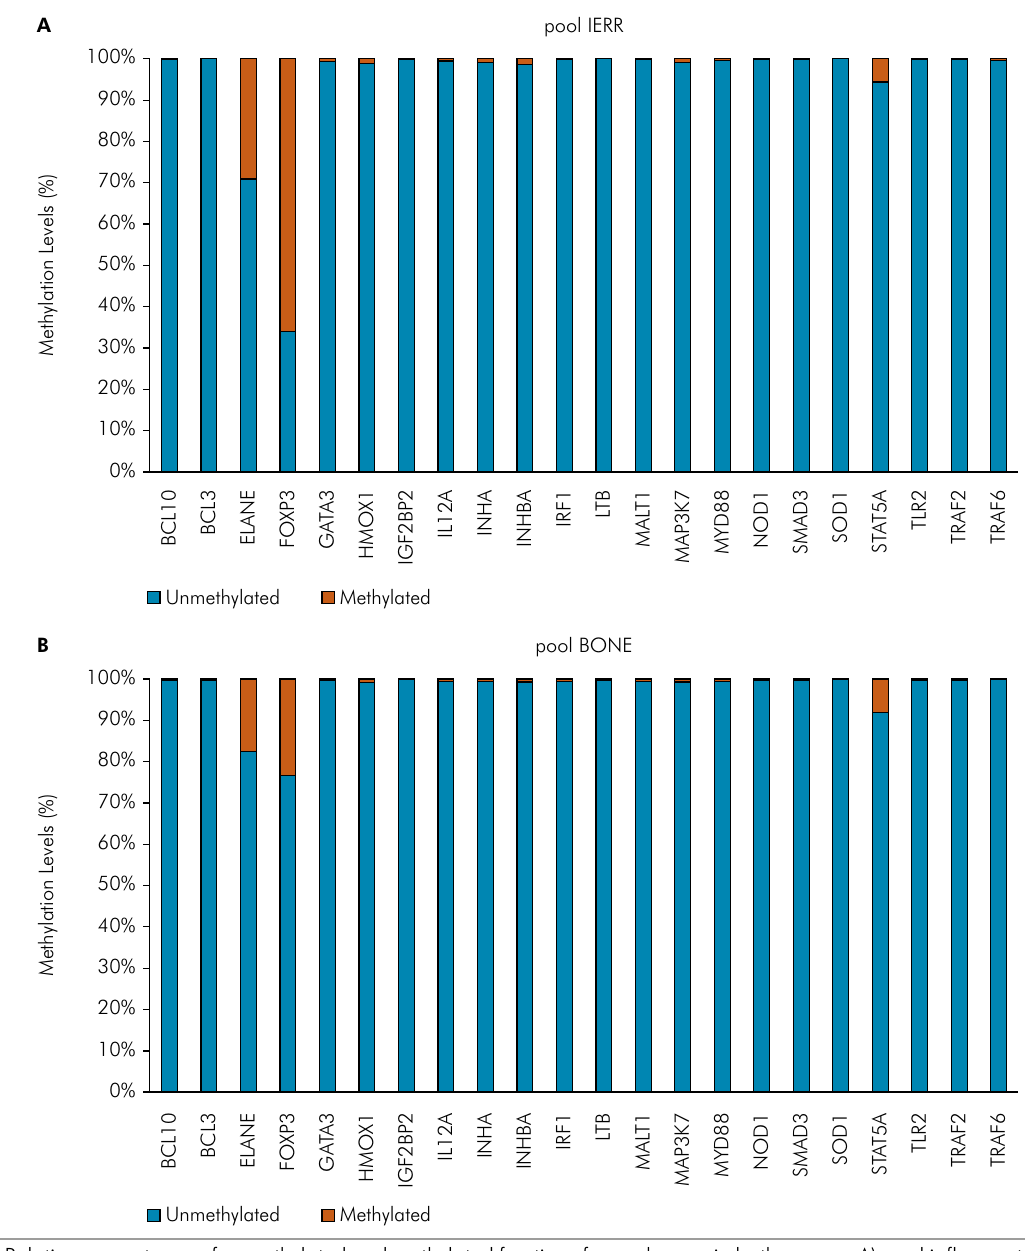
Figure. Relative percentages of unmethylated and methylated fractions for each gene in both groups. A) pool inflammatory external root resorption (IERR); and B) pool bone. FOXP3 (p < 0.00) and ELANE (p = 0.054) showed the highest levels of DNA methylation in the IERR group when compared to the bone